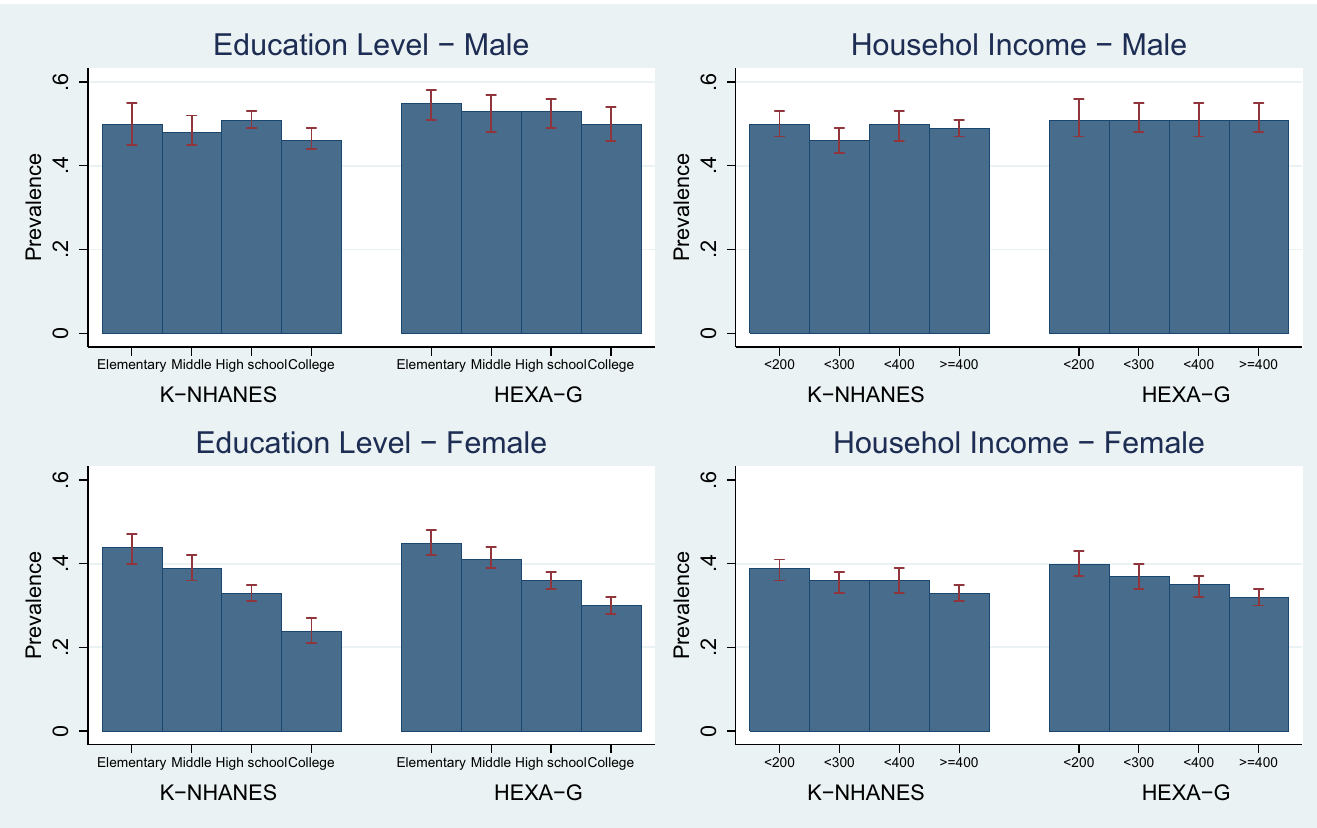
Fig 4. Age-standardized prevalence: Elevated blood pressure. K-NHANES: Korea National Health and Nutrition Examination Survey; HEXA-G: Health Examinees- Gem. Elevated blood pressure (BP) systolic BP (cid:21) 130 or diastolic BP (cid:21) 85 mm Hg or specific treatment for this hypertension.